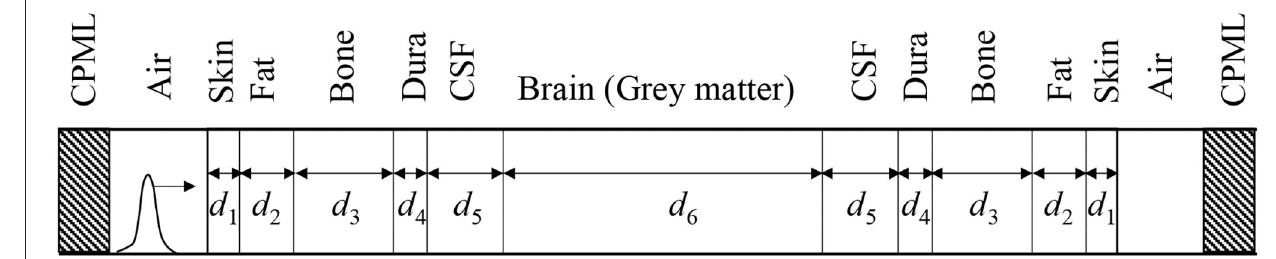
FIGURE 2 | Multilayer model consisting of six biological tissues.